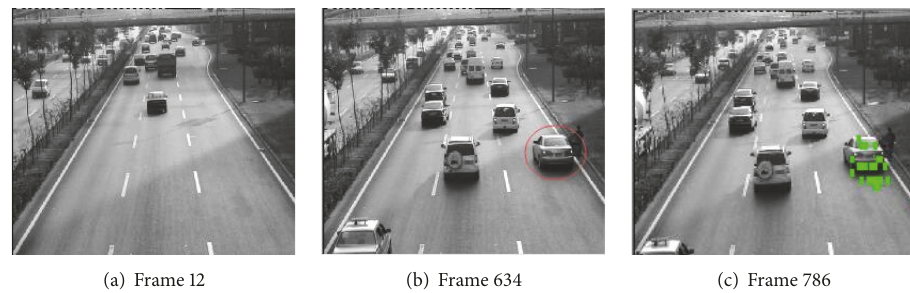
Figure 8: Xi’an South Second Ring Road parking test